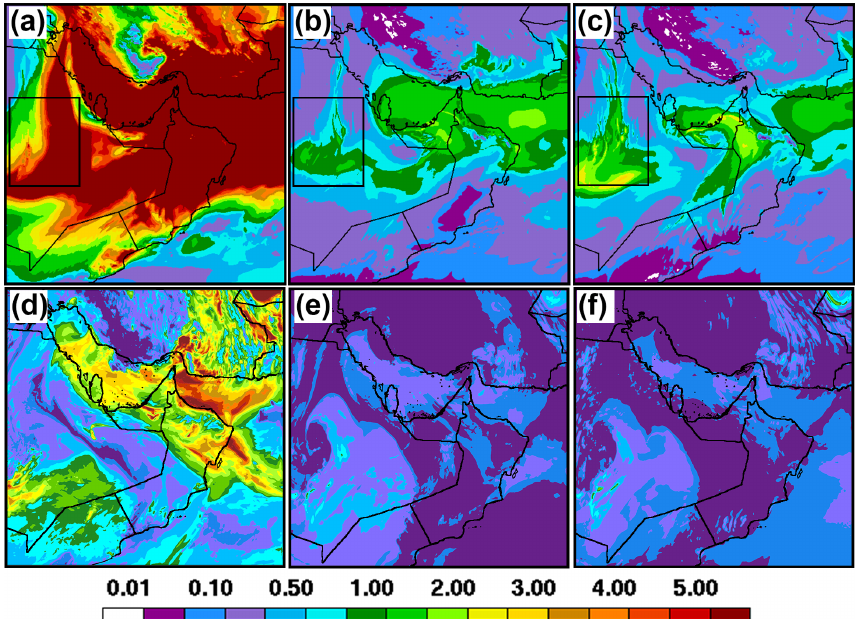
Figure 6. Simulated total AOD at 550nm from (a–c) RAMS and (d–f) WRF-Chem simulations at 09:30UTC on 4 August 2016 using the (a, d) Idealized dust lofting, (b, e) Ginoux dust sources, and (c, f) Walker dust sources. The black box over the central Arabian Peninsula denotes the analysis region shown in Fig.